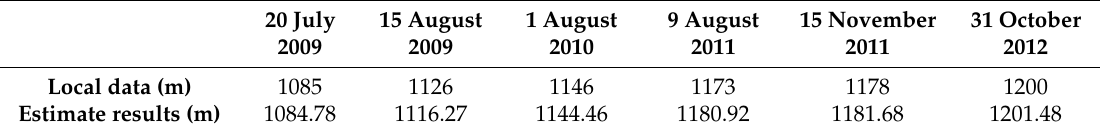
Table 2. Comparison between local water level information and estimated results of Xiaowan Dam.